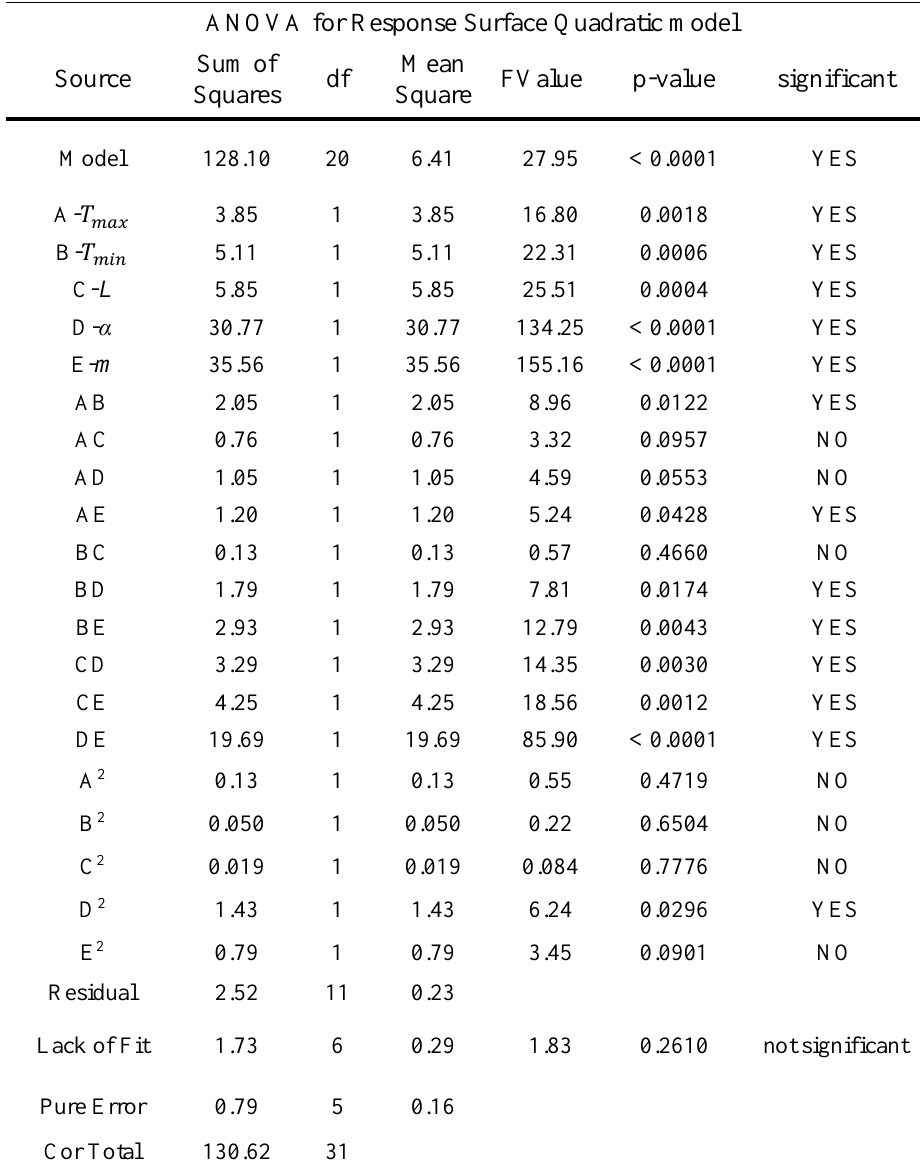
Table 8. Statistical analysis for investigating the relation between SA parameters and the computational time (UA-CSLP case